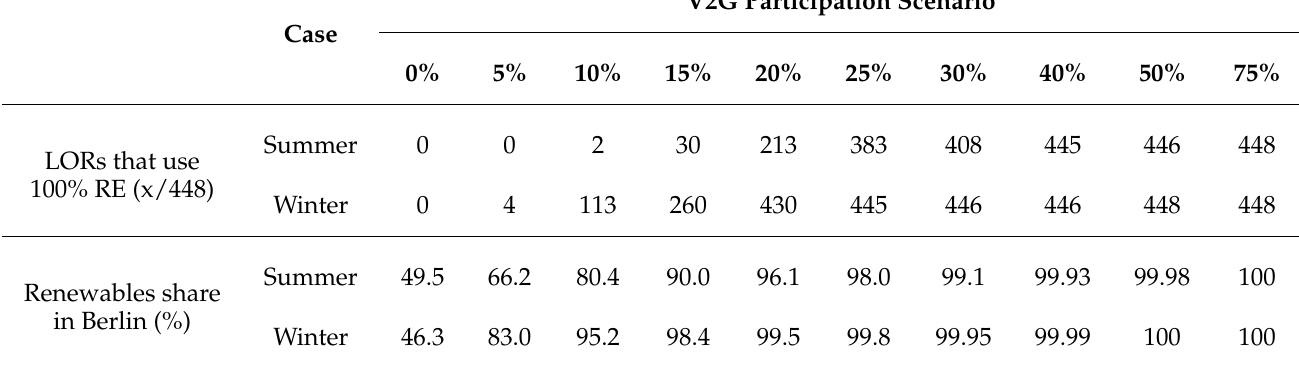
Table 1. Number of LORs whose energy demand is met entirely by renewables and share of renewable energy in Berlin for the ten V2G participation scenarios investigated.